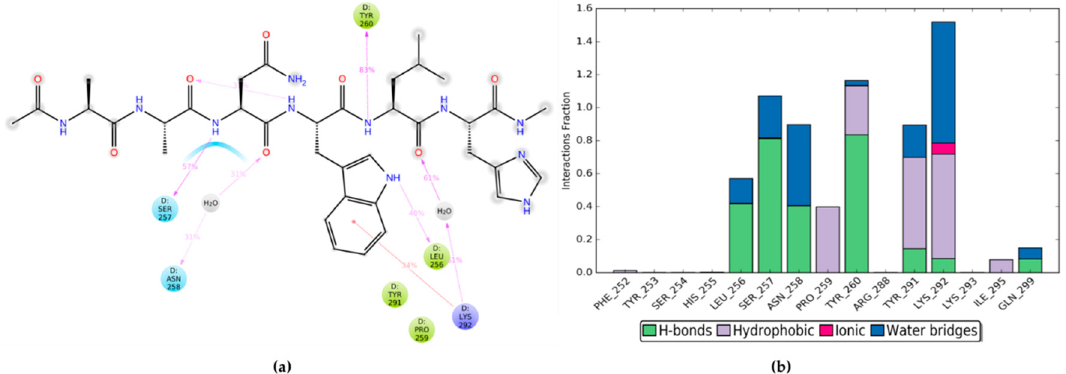
Figure 4. (a) Diagram of HOXA9 hexapeptide interactions with PBX1 residues during MD simulation; (b) bar chart of protein-ligand interaction occurrences during MD simulation.